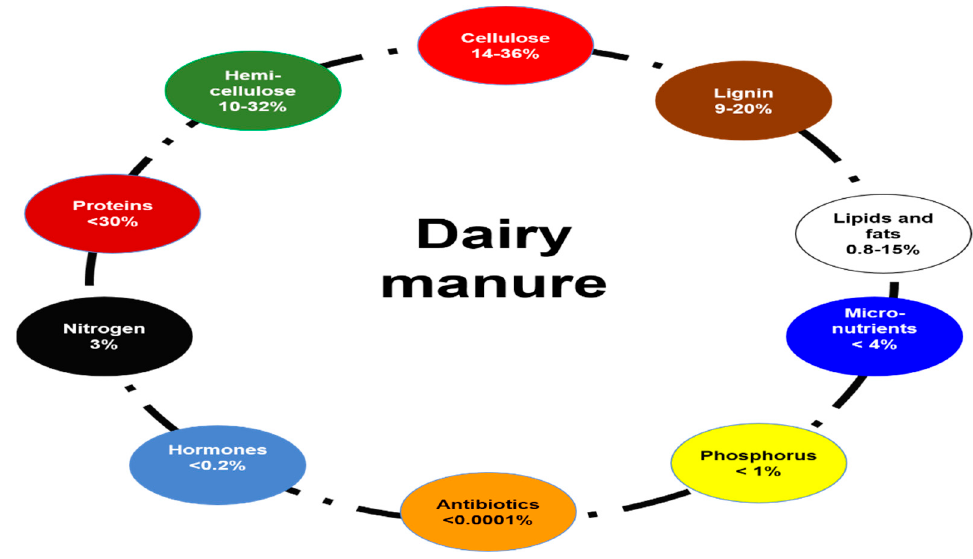
Figure 2. Composition of dairy manure (mass percent). The figures is based on data from [23,24,28–39].